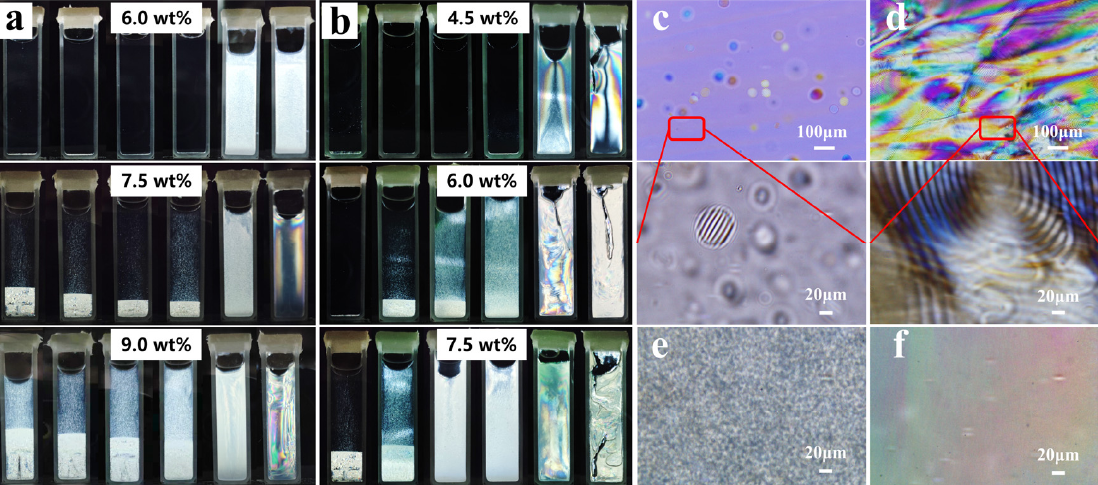
Figure 4. ( a ) Photos of CNC/PAAS mixtures taken between crossed linear polarizers at different CNC concentrations (6.0 wt%, 7.5 wt%, and 9.0 wt%, respectively); the ratio of PAAS is 0 wt%, 1.0 wt%, 2.0 wt%, 3.0 wt%, 4.0 wt%, and 5.0 wt% in order, from left to right. ( b ) Photos of CNC/COS mixtures at different CNC concentrations (4.5 wt%, 6.0 wt%, and 7.5 wt%, respectively); the ratio of COS is 0 wt%, 1.0 wt%, 1.5 wt%, 2.0 wt%, 2.5 wt%, and 3.0 wt% in order, from left to right. ( c ) The POM patterns of the isotropic phase after phase separation ( top ) and its partial enlarged view ( below ). ( d ) The POM patterns of the anisotropic phase ( top ) and its partial enlarged view ( below ). The POM patterns of ( e ) CNC/PAAS 4 . 0 mixture and ( f ) CNC/PAAS 5 . 0 mixture.